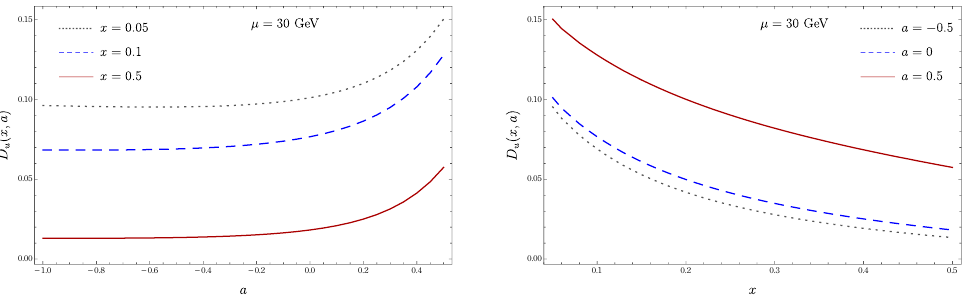
Figure 2 . The difference D u ( x, a ) between angularity beam function and FJF for the case of u quark at µ = 30 GeV. The left and right sub-figures represent a and x dependency respectively. multiplication of δ ( τ ) . The differences is sensitive to a and z only and remains constant a with respect to τ a